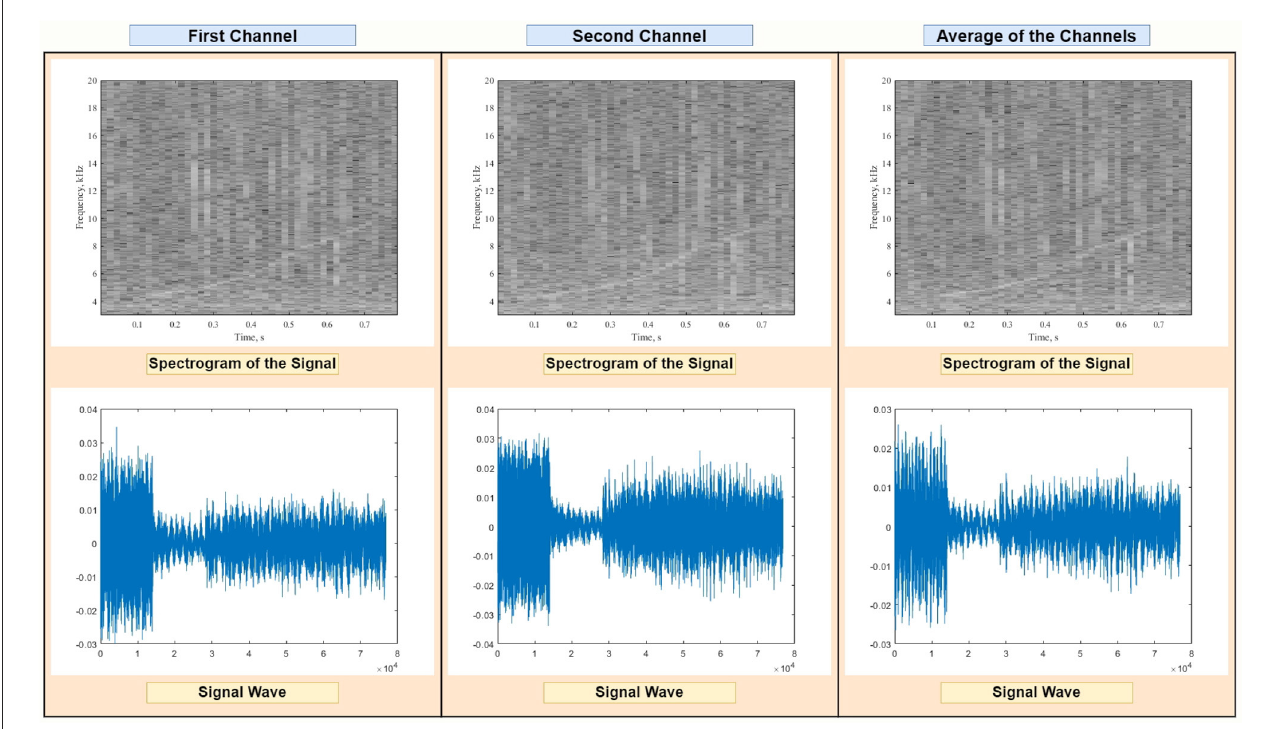
FIGURE2 Visualization of the spectrogram (Top) and raw audio data (Bottom) of a representative sample containing a dolphin whistle (curved line in the time-frequency plots). Our detection system receives as input the average of the two recording